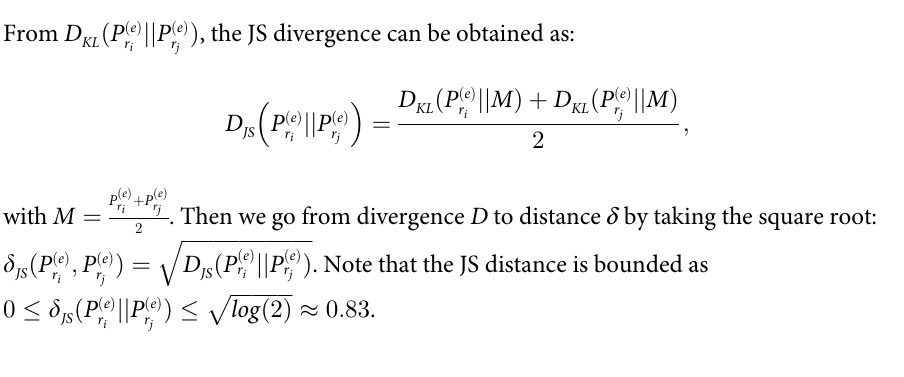
ffiffiffiffiffiffiffiffiffiffiffiffi p log ð 2 Þ